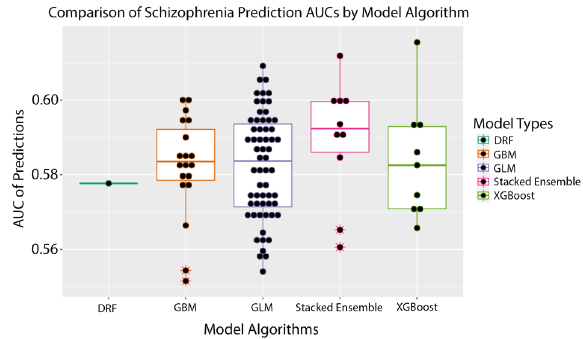
Figure 1. This boxplot figure presents the results of the machine learning predictions. We created 100 different datasets. For each dataset, we used the same set of schizophrenia patients with a distinct set of age matched people from the general UK Biobank population as controls. Then H2O was used to perform a grid-search of possible best algorithms. The best performing algorithm was then reported with an AUC. The differences between algorithms is reported here. The machine learning algorithms tested were distributed random forests (drf), gradient boosting machine (gbm), general linear model (GLM), stacked ensemble (a combination of the other four algorithms) and XGBoost